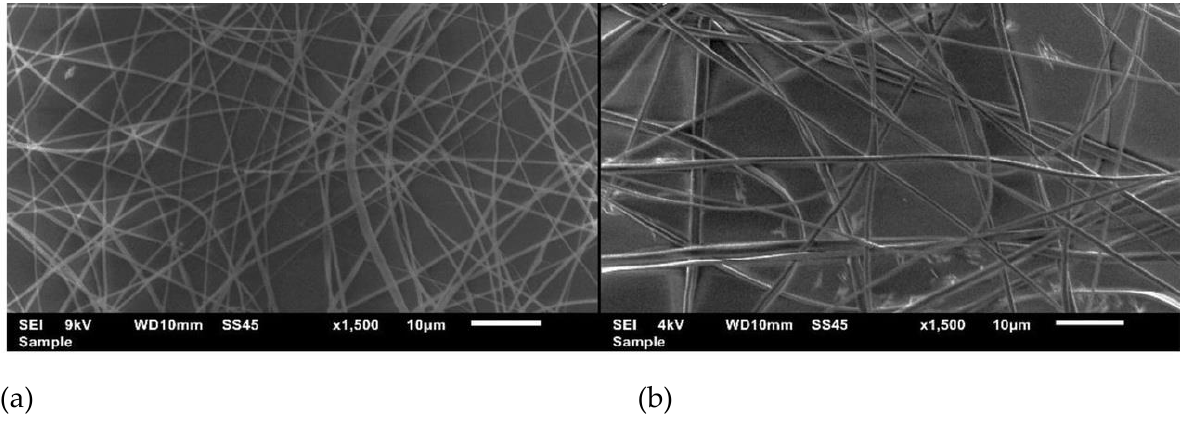
Figure 3. Scanning electron microscopy micrographs of cellulose acetate (CA) nanofibers ( a ) and cellulose acetate/methylene blue (CA/MB) nanofibers ( b ) prepared under the supply voltage, poly- mer concentration, and flow rate equal to 10 kV, 17%, and 1 mL per h, respectively [49].